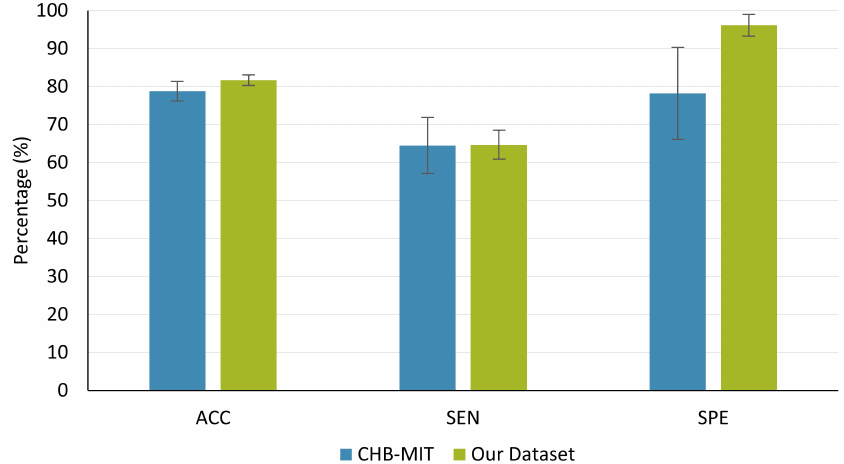
Figure 3. Average performance computed using the RCV validation method on the two data sets. The bar chart displays the average performance metrics and the standard error of the